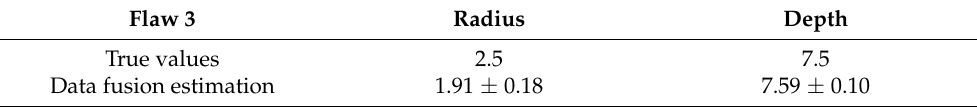
Table 4. ANNs estimations of radii and depths (mm) obtained for the third measured